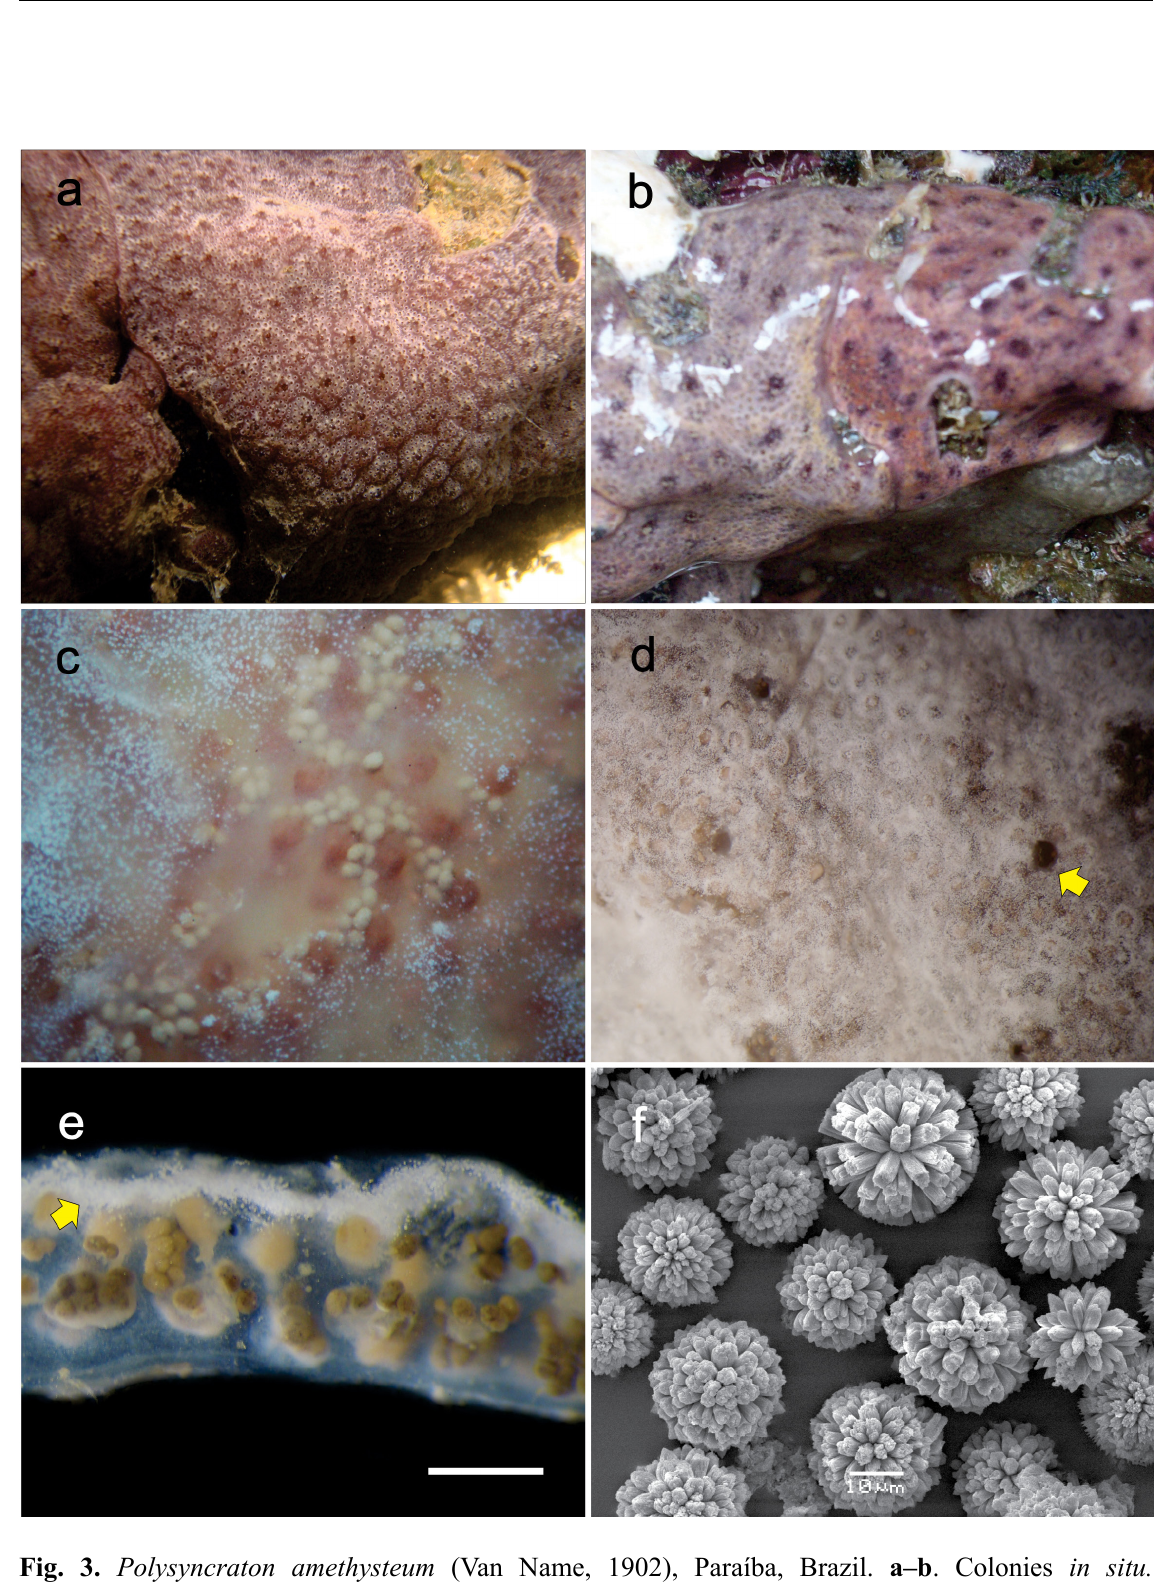
Fig. 3. Polysyncraton amethysteum (Van Name, 1902), Paraíba, Brazil. a–b . Colonies in situ. c–d . Colony surface detail (arrow indicates one cloacal aperture) (DZUP POSC-14 and DZUP POSC- 13, respectively). e . Cross section of the colony, with thin layer of spicules (arrow) (DZUP POSC-14). f . Spicules. Scale bars: e = 1 mm; f =